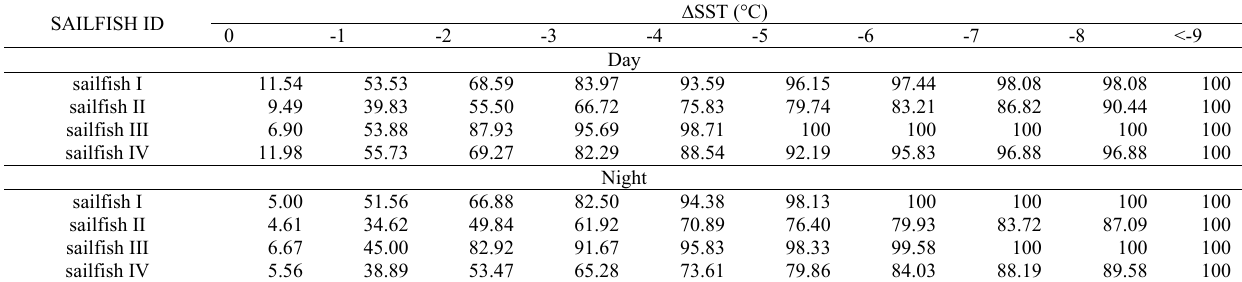
Table 3. Cumulative percentage of temperature readings from pop-up satellite archival tags deployed on sailfish in the southeast coast of Brazil expressed as differences from daily calculated sea surface temperature Δ SST (°C) by day and night period (transition period was excluded of this